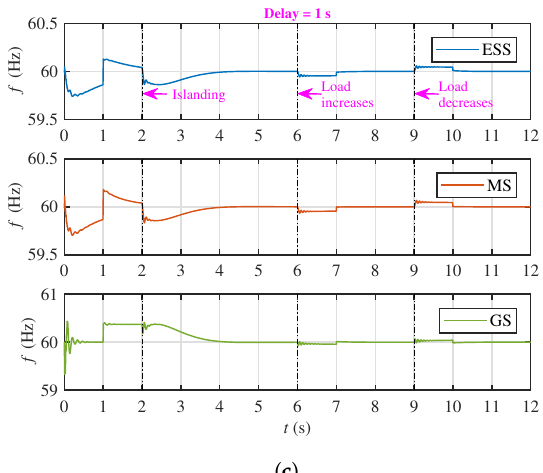
Figure 11. Frequency restoration test for DG units with different communication latencies: ( a ) 300ms ( b ) 600ms and ( c )